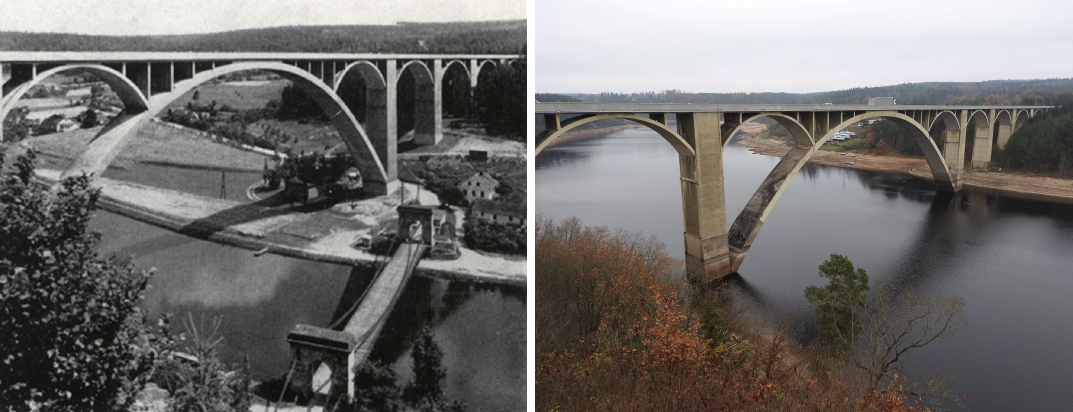
Figure 6. Arch bridge at Podolsko, 1939–1942 (left – during construction still with the former chain bridge [7], right – at